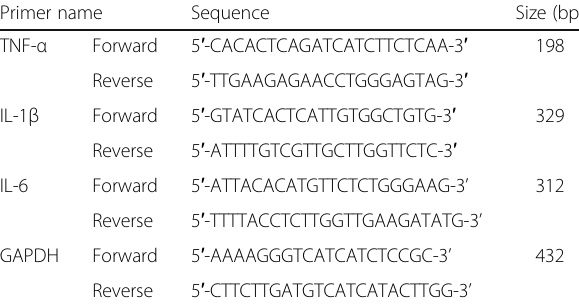
Table 2 mRNA of forward and reverse primers